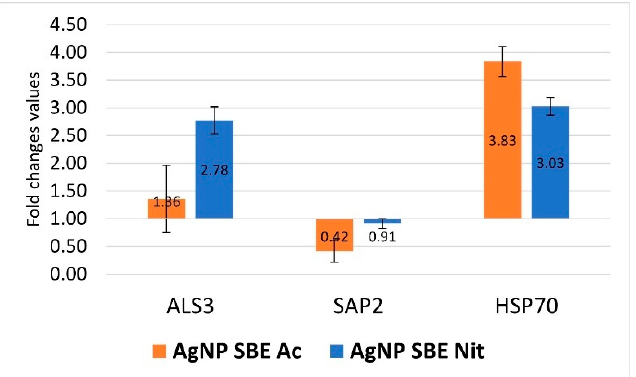
Figure 5. The influence of the AgNP SBEs on C. albicans gene expression for ALS3 , SAP2 , HSP70 .